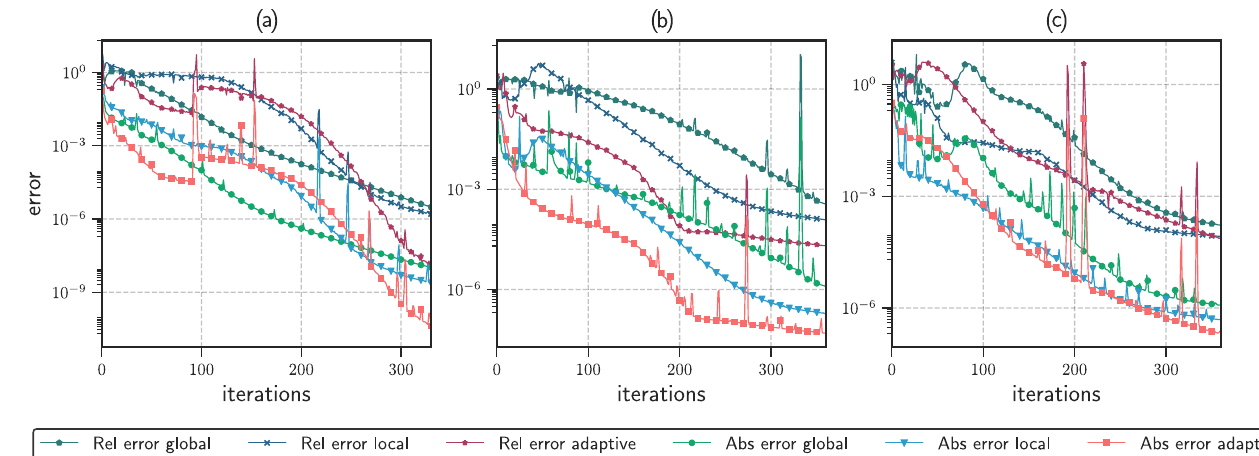
Fig. 4 Relative and absolute error versus the number of iterations. We implemented VQSE for states of: a n = 6, b n = 8, and c n = 10 qubits. In all cases, the ansatz for V ( θ ) was given by three layers of the Layered Hardware Ef fi cient Ansatz of Fig. 3(b, top). Each curve represents the absolute or relative error (denoted Abs error or Rel error, respectively) of (18) obtained by training V ( θ ) when employing an adaptive, fi xed- local, or fi xed-global Hamiltonian. The number of iterations was 330 for ( a ) and 360 for ( b ) and ( c ). For the adaptive runs, we employed Algorithm 1, with the Hamiltonian being updated every 30 iterations. In each case, the adaptive approach performs the best as it achieves the smallest